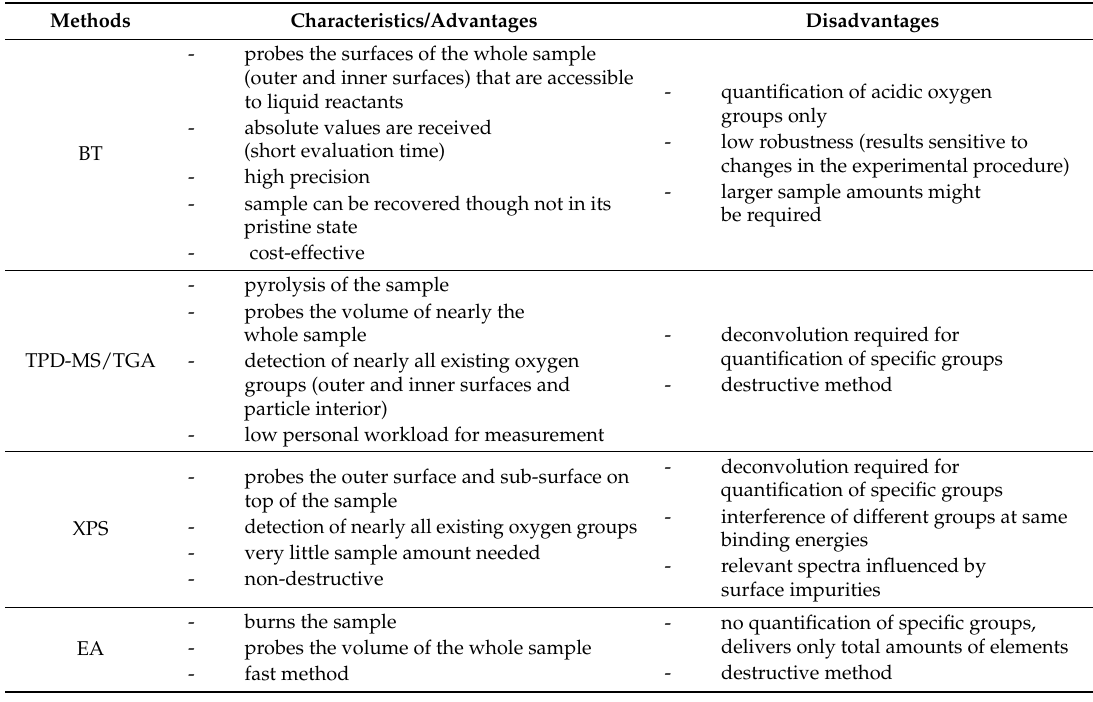
Table 3. General characteristics, advantages, and disadvantages of methods for the characterization of oxygen-containing surface groups.